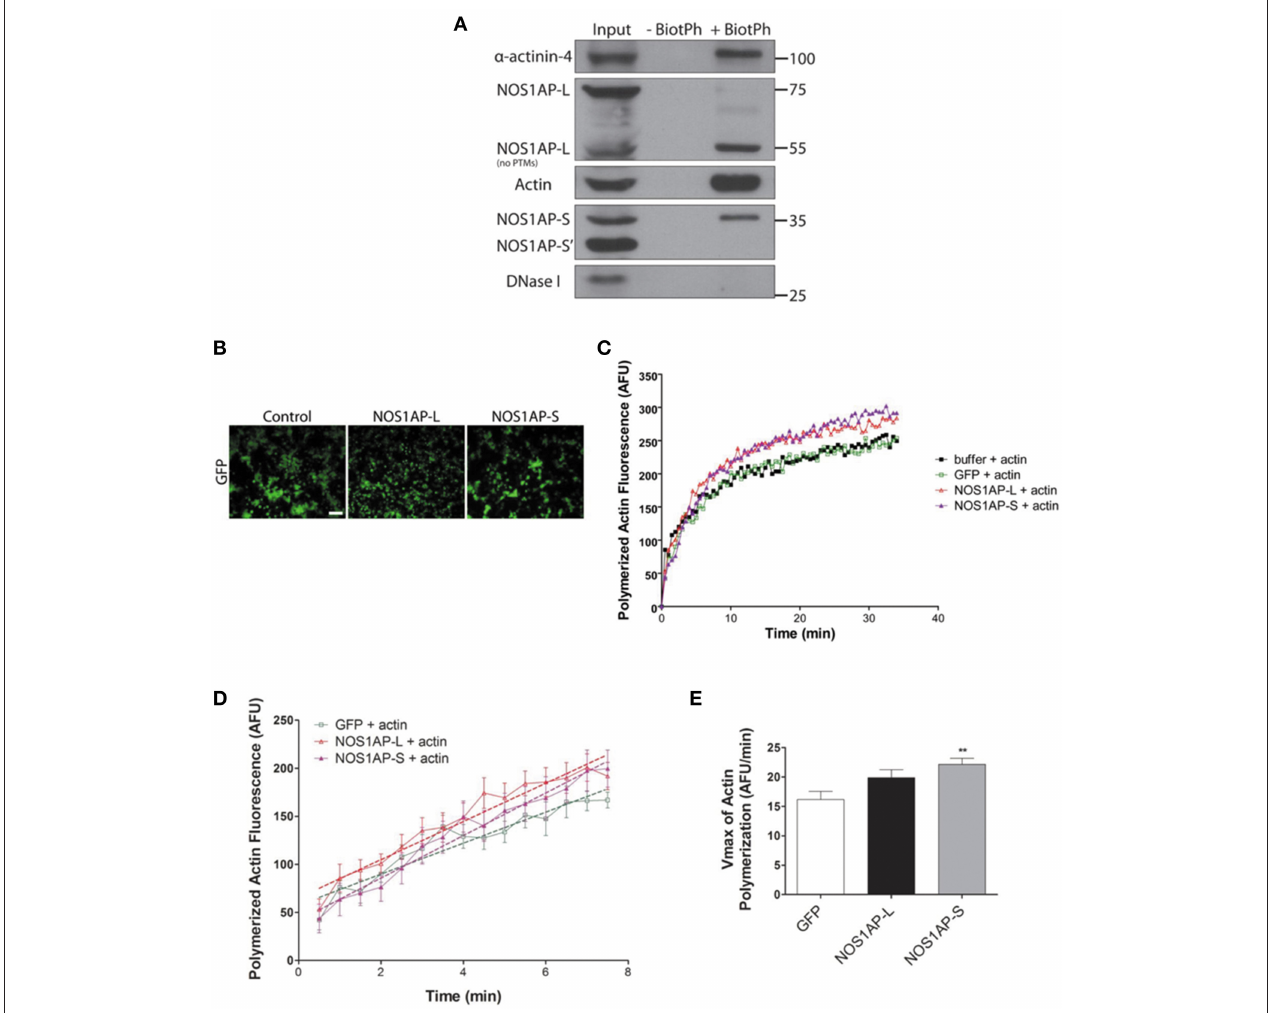
FIGURE 4 | NOS1AP-L and NOS1AP-S associate with F-actin and promote actin polymerization. (A) Representative blot showing immunoprecipitation of phalloidin-bound F-actin and NOS1AP from adult rat brain lysate. Tissue was homogenized and cells were lysed in F-actin stabilization buffer. Samples were incubated with or without (negative control) biotinylated-phalloidin followed by precipitation of the captured complexes with streptavidin-linked magnetic beads. Precipitated fractions were then subjected to SDS-PAGE and sequentially immunoblotted to detect NOS1AP isoforms (NOS1AP-L, NOS1AP-S, and NOS1AP-S’), alpha-actinin-4, Dnase I, and actin. Pull down of F-actin also captures alpha-actinin-4 (positive control). BiotPh, biotin–phalloidin; PTMs, post-translational modifications. (B) Representative images of HEK293T cells expressing GFP (control), GFP-NOS1AP-L, or GFP-NOS1AP-S. Scale bar = 100 µ m. (C) Pyrene-actin polymerization assay was performed using a 1:10 mixture of pyrene-labeled muscle actin to unlabeled non-muscle actin. Polymerization of actin was initiated by the addition of polymerization buffer at time 0.5 min. The black trace depicts actin in the presence of lysis buffer alone, green trace depicts effect of adding HEK293T cell lysate from cultures expressing GFP, red trace depicts effect of adding HEK293T cell lysate from cultures expressing GFP-NOS1AP-L, and purple trace depicts effect of adding HEK293T cell lysate from cultures expressing GFP-NOS1AP-S. (D) Effects of NOS1AP-L and NOS1AP-S on velocity during the growth phase of actin polymerization. Dotted lines are linear regression of polymerization curves in (B) from time 0.5 to 7.5 min to determine V max -values. (E) , V max data values for actin polymerization kinetics shown in (D) . Error bars indicate ± s.e.m. AFU, arbitrary fluorescence units. n = 10 polymerization reactions, buffer + actin; n = 9, GFP + actin; n = 13, NOS1AP-L + actin; n = 12, NOS1AP-S + actin. ** p < 0.01 vs. GFP + actin. p -values were determined by one-way ANOVA followed by Dunnett’s Multiple Comparisons